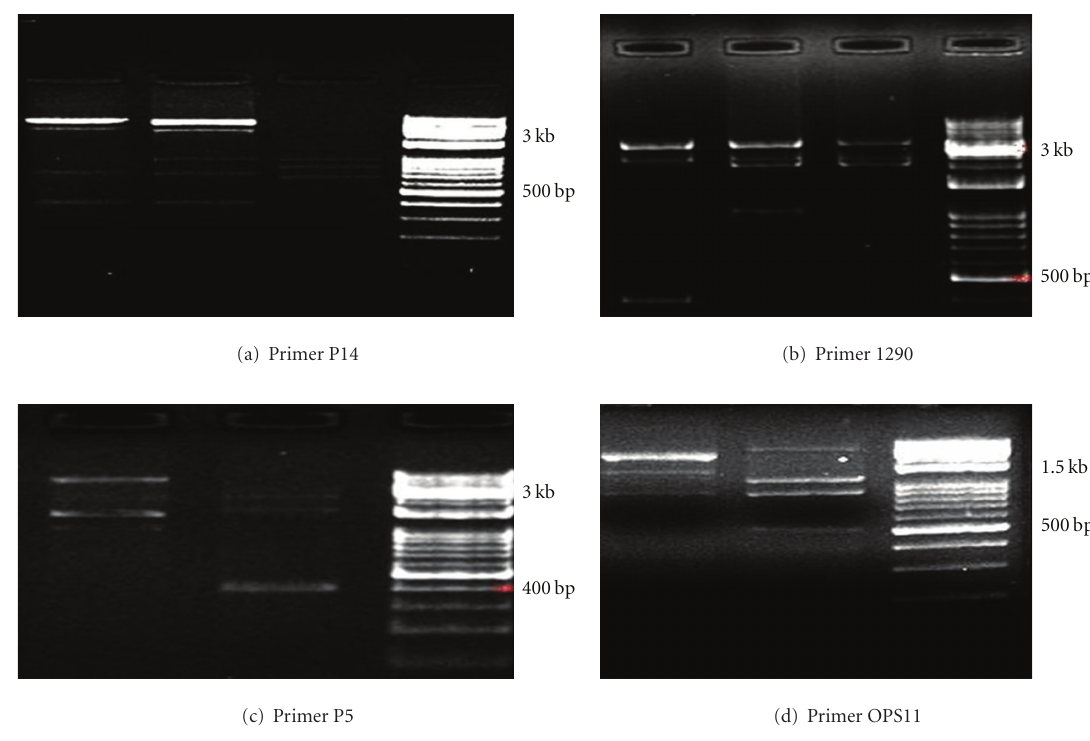
Figure 2: PCR gel RAPD products using primer p14 showing 3–5 bands with molecular weight 350–3000 bp (a), OPS11 primer showing 3-4 bands with molecular weight of 540–3290 bp (d), primer 1290 showing 3-4 bands with molecular weight of 400–3400 bp (b), primer p5 showing 3 bands with molecular weight of 400–4000 bp